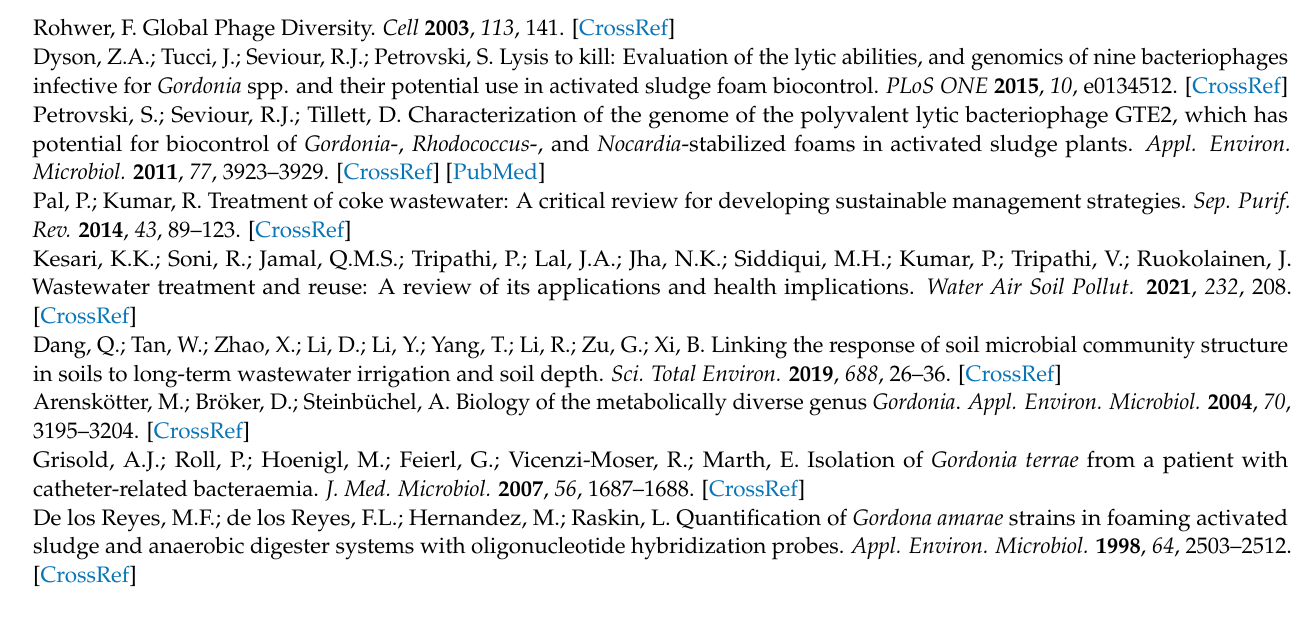
resolvase gene; Figure S2: Phamerator map of the hicA -like toxin gene; Figure S3: Neighbor-joining trees; Figure S4: Dot plots; Figure S5: Average nucleotide identities; Table S1: Gordonia cluster DR bacteriophages included in the comparative analyses; Table S2: Bacteriophages included as outgroups in the comparative analyses; Table S3: Host bacteria included in the comparative analyses